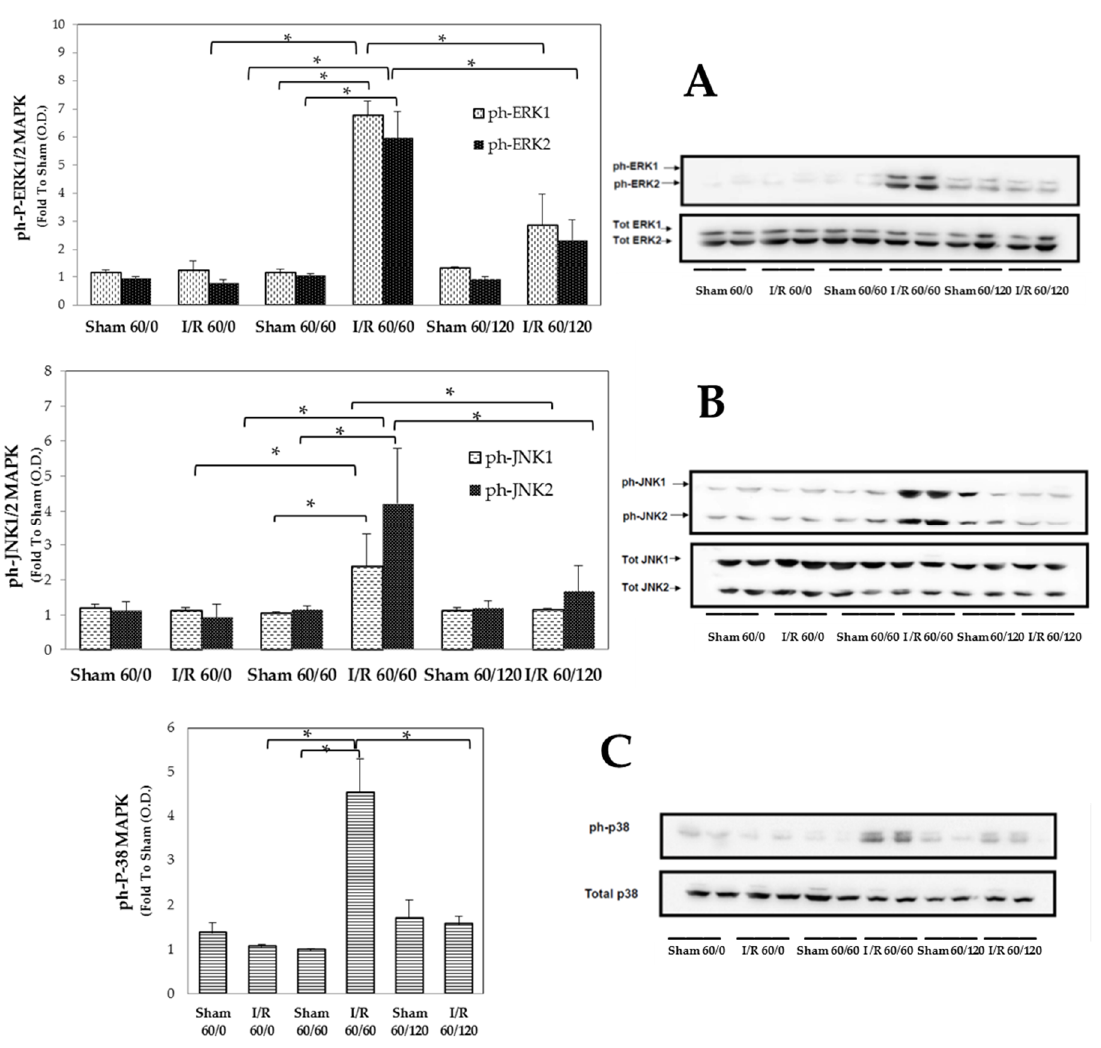
Figure 3. Hepatic MAPK pathways (ERK1 / 2, JNK1 / 2 and p38) at the end of ischemia and after 60 min or 120 min reperfusion. Panel ( A ): ERK1, * p = 0.025; ERK2, * p = 0.025; Panel ( B ): JNK1, * p = 0.028; JNK2, * p = 0.043; Panel ( C ): P-38, * p = 0.014. The results are reported as the mean ± SE of 6 different experiments.